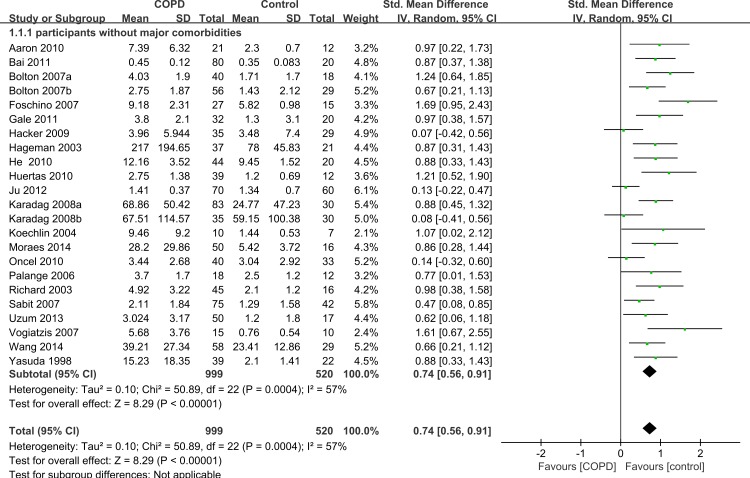
Forest plot for subgroup analysis by comorbidities.Forrest plot of subgroup studies in the meta-analysis that investigated the association between serum IL-6 concentrations and COPD patients without major comorbid conditions, using a random-effects model. COPD, chronic obstructive pulmonary disease; SD, standard difference; SMD, standard mean difference; CI, confidence interval.